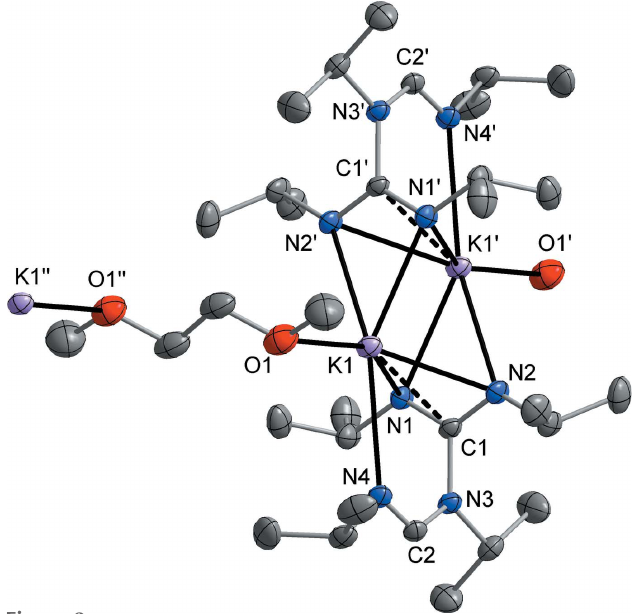
Figure 2 Molecular structure of the title compound in the crystal. Displacement ellipsoids are drawn at the 50% probability level, hydrogen atoms omitted for clarity. Symmetry codes: ( 0 ) (cid:2) x , (cid:2) y , 2 (cid:2) z ; ( 00 ) (cid:2) x , (cid:2) 1 (cid:2) y , 2 (cid:2) z .